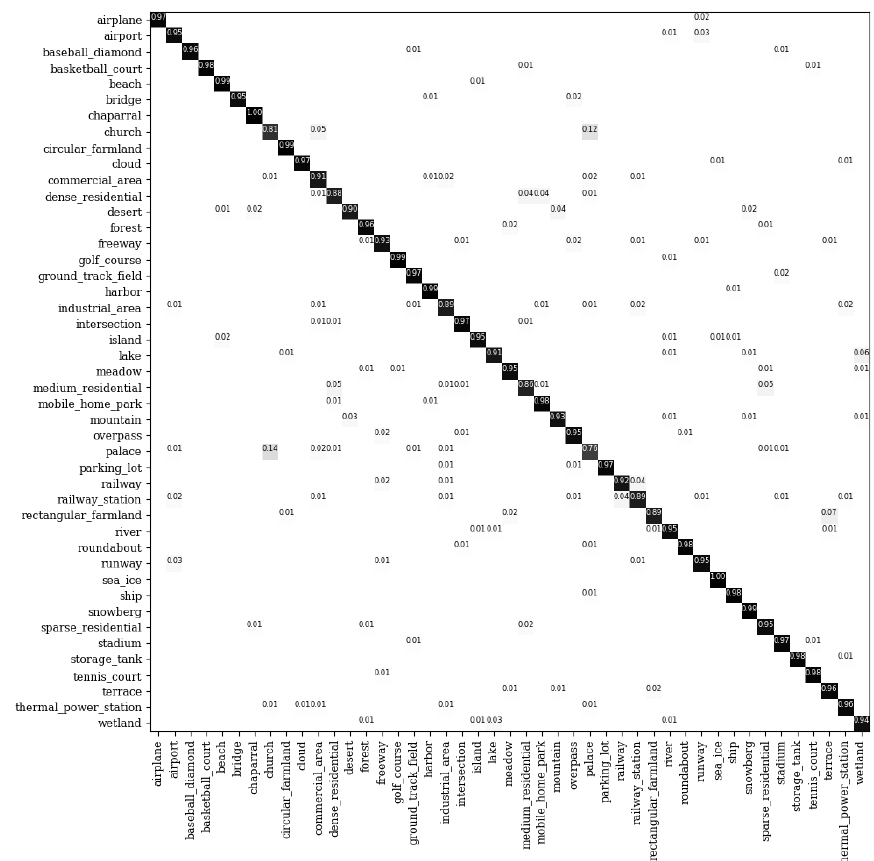
Figure 11. The confusion matrix for the NWPU-RESISC 45 dataset under the 20% training samples.